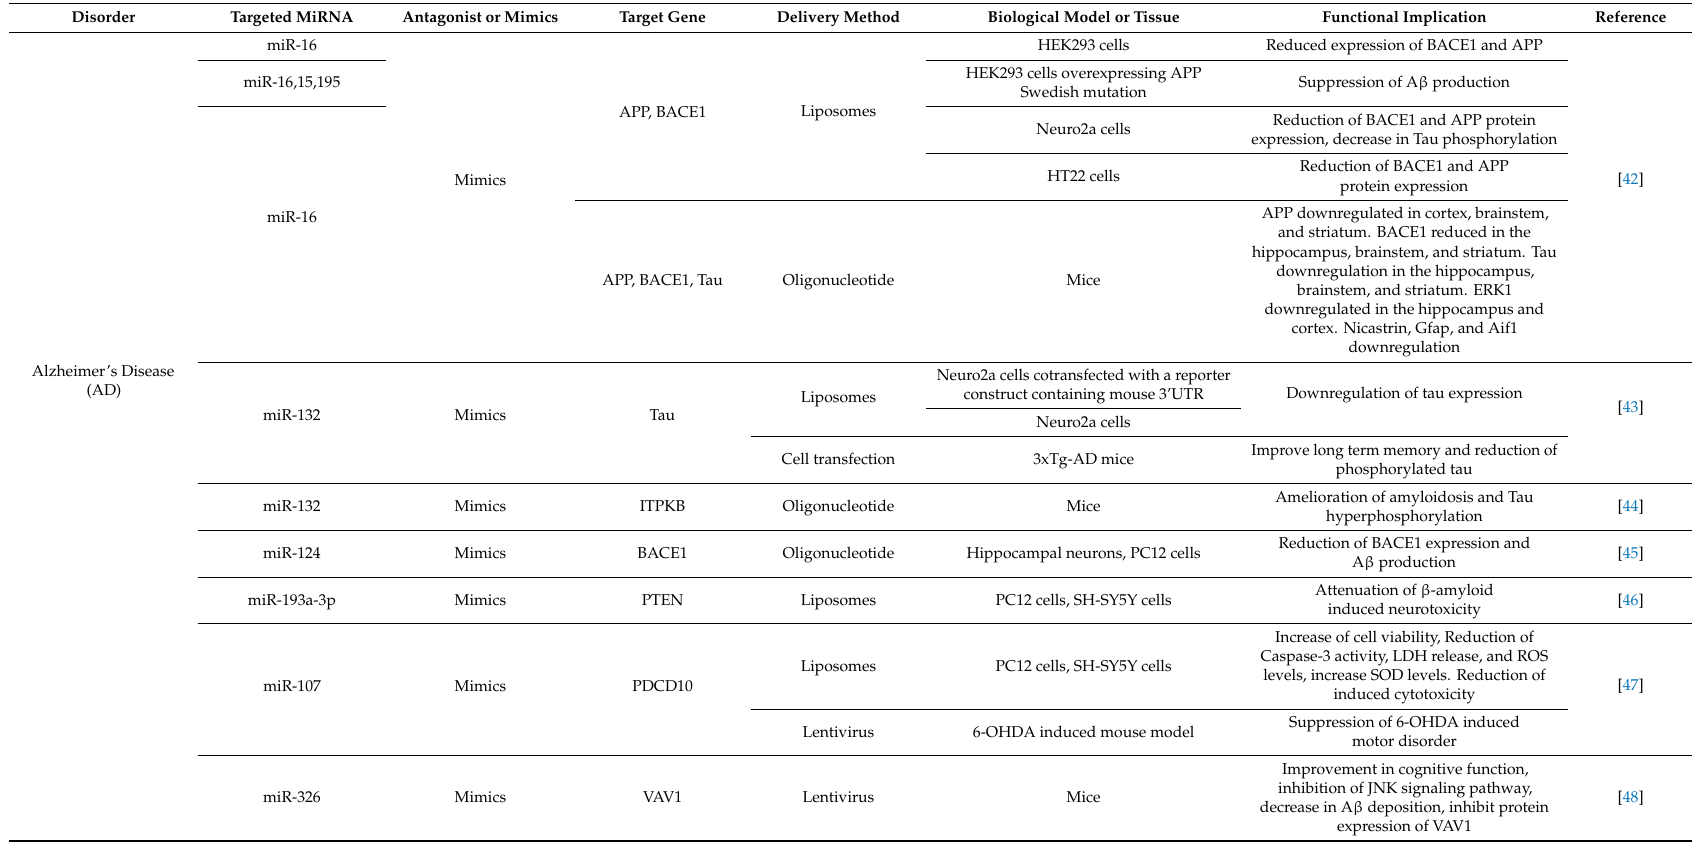
Table 1. Functional implications and therapeutic potential of di ff erent miRNAs associated with important neurodegenerative